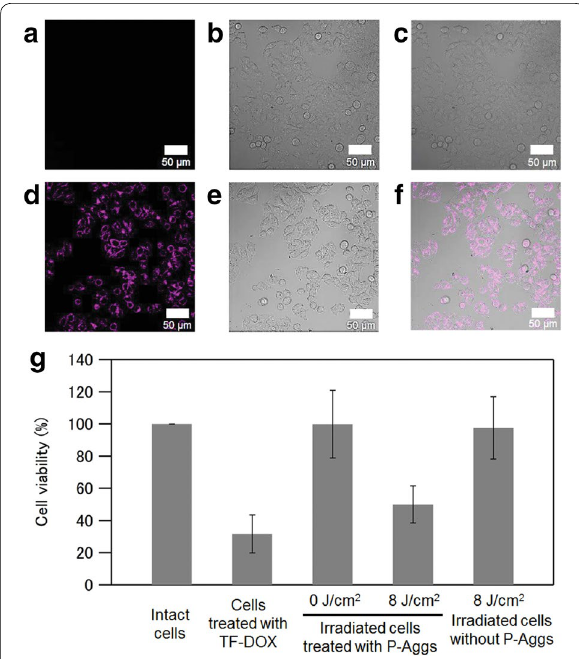
Fig. 5 Light-induced cellular uptake of Tf or a chemotherapeutic drug through degradation of P-Aggs. a – c Confocal microscopy images of DLD1 cells treated with P-Aggs consisting of SA and AF647-labeled caged Tf before light irradiation. d – f Those after light irradiation at 8 J cm − 2 . a , d AF647-fluorescence images, b , e differen- tial interference contrast (DIC) images, c , f each merged image of ( a , b ) or ( d , e ), respectively. The scale bars are 50 μm. g Cell viabilities of the DLD1 cells treated with doxorubicin-modified Tf (Tf-DOX) or with P-Aggs consisting of SA and the caged Tf-DOX before and after light irradiation at 8 J cm − 2 (Figure reproduced with permission from: Ref. [62]. Copyright (2016) with permission from John Wiley and